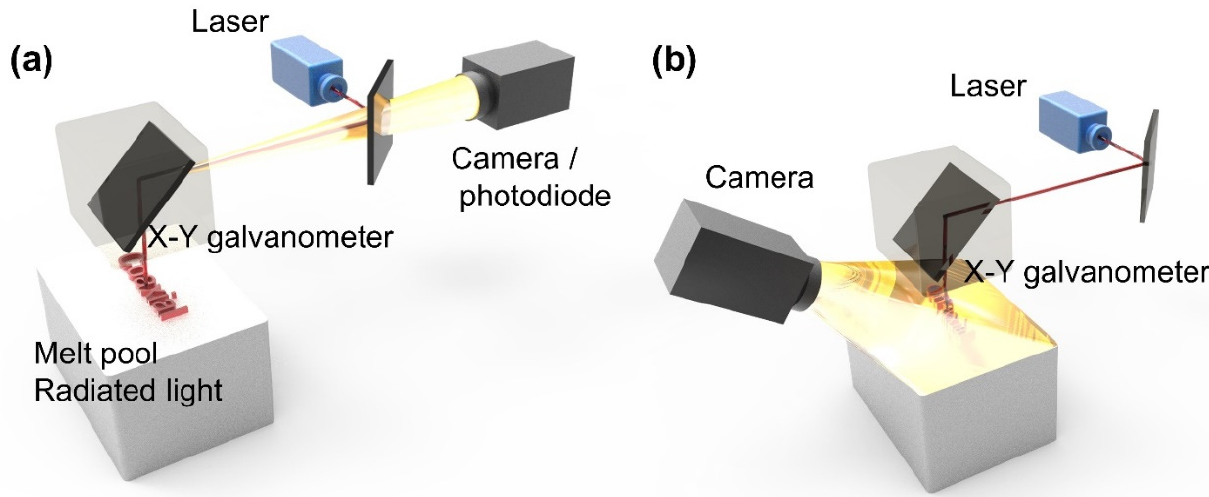
Figure 4. L-PBF in situ detection system: ( a ) coaxial (sharing the optical path with the laser); ( b ) off-axial (at a slight angle to the laser optical path).